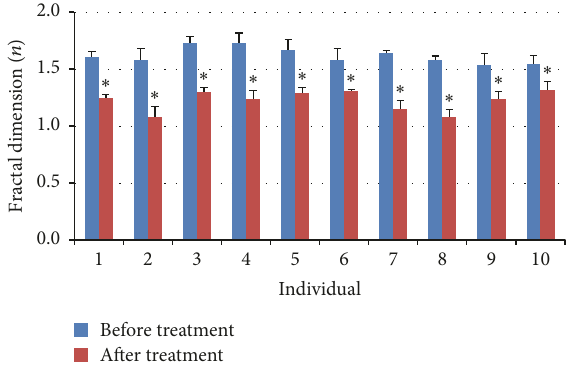
Figure3:Fractaldimensionofmovementtracks(10minutes)before and after treatments of observed individuals. ∗ indicates significant difference, 𝑝 < 0.01